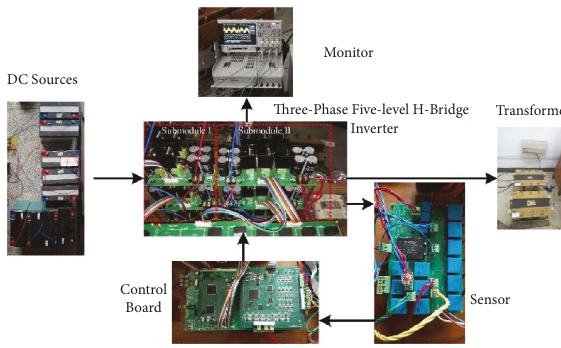
Figure 5: Experimental